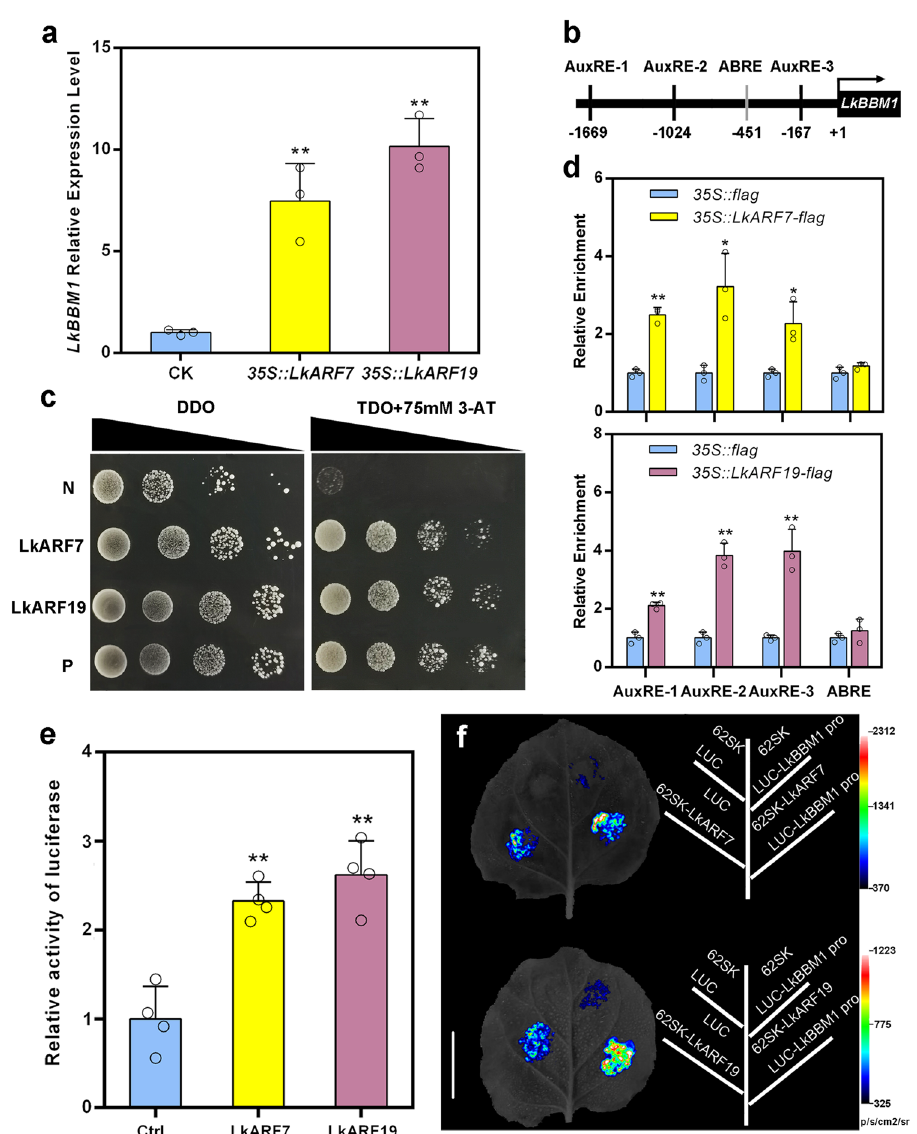
Fig. 5 LkARF7 and LkARF19 directly bind to the LkBBM1 promoter and activate its expression. a Activation of LkBBM1 expression by transient overexpression of LkARF7 and LkARF19 , respectively. The value from the empty vector (CK) was set to 1.0. b Yeast one-hybrid analysis of interactions between LkARF7/19 and the LkBBM1 promoter. P, Positive control (p53HIS2 + pGAD53T); N, Negative control (pHIS2-LkBBM1 promoter + pGADT7); LkARF7 (pHIS2-LkBBM1 promoter + pGADT7-LkARF7); LkARF19 (pHIS2-LkBBM1 promoter + pGADT7-LkARF19). DDO, SD/-Trp-Leu; TDO, SD/-Trp-Leu- His. c Diagram of the LkBBM1 promoter showing the relative positions of three auxin response elements (AuxRE) and one abscisic acid response element (ABRE). d Binding of LkARF7 and LkARF19 with the LkBBM1 promoter using ChIP-qPCR assay. The relative abundance of LkBBM1 promoter fragments